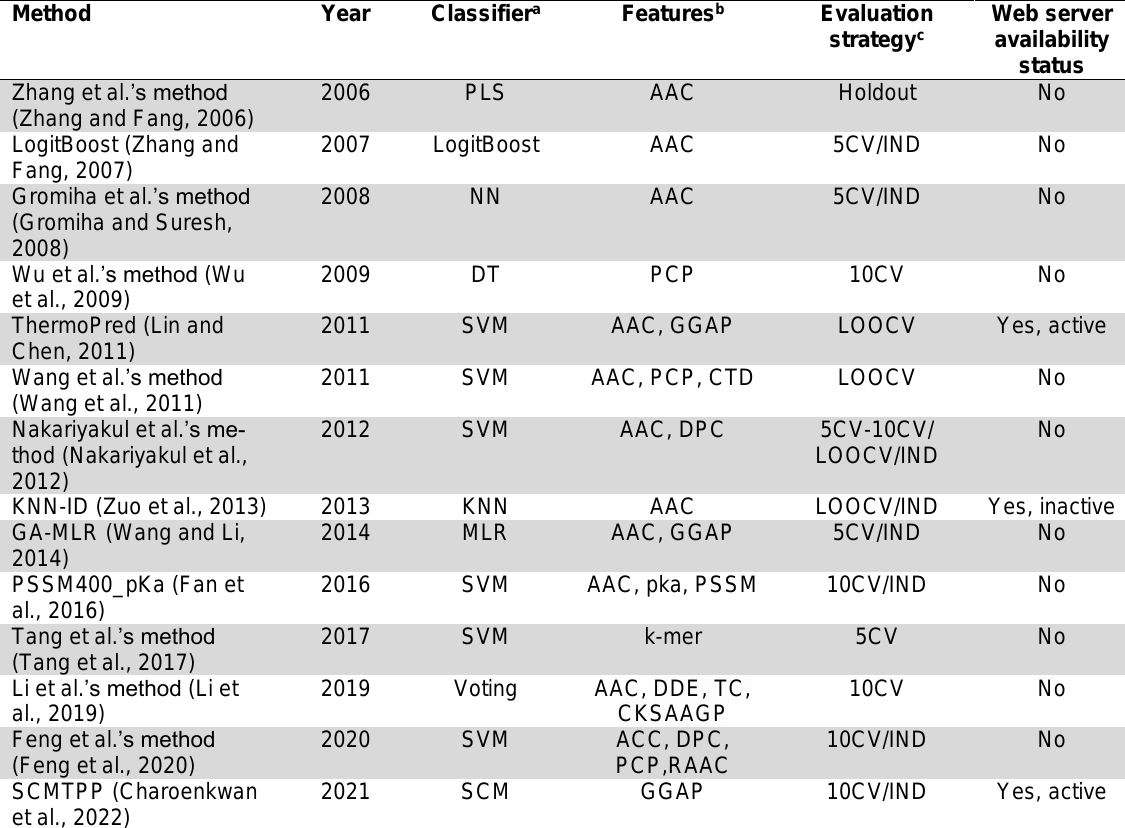
Table 1: A list of currently available machine learning-based methods for TPP identification summarized in this